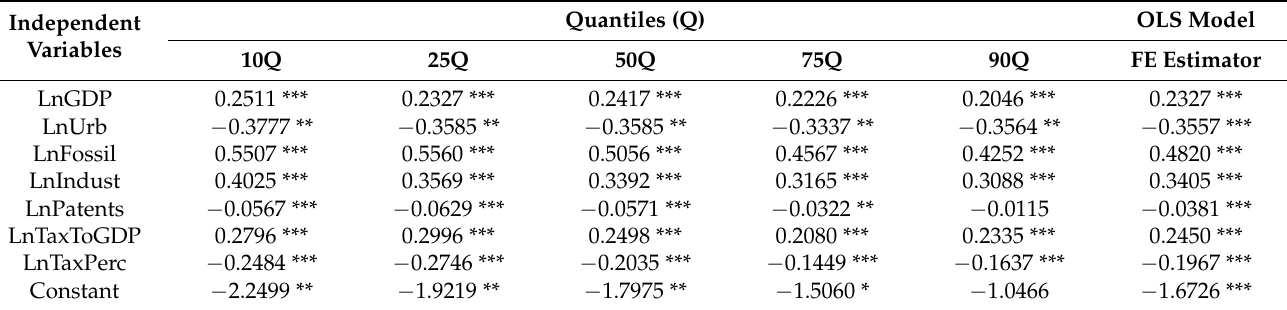
Table 9. Estimations for LnCO 2